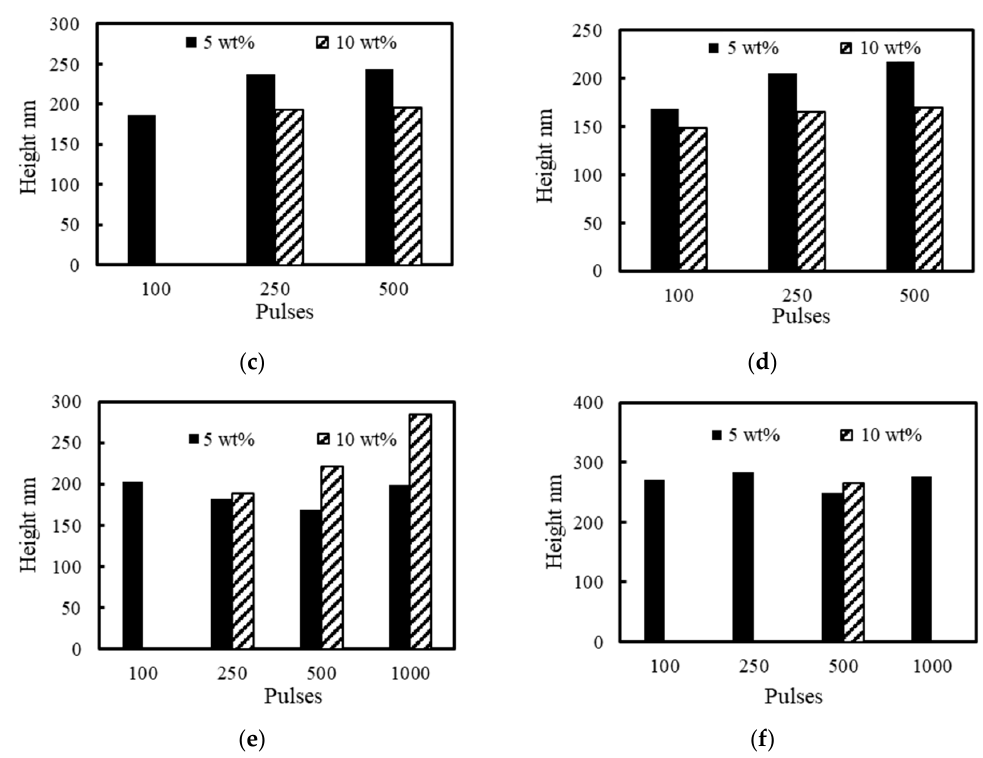
Figure 9. Relationship between the height of LIPSSs and laser irradiation conditions under ( a ) air, ( b ) water, ( c ) 5 and 10 wt% NaCl solutions, ( d ) 5 and 10 wt% NaNO 3 solutions, ( e ) 5 and 10 wt% Cu(NO 3 ) 2 solutions and ( f ) 5 and 10 wt% CuSO 4 solutions.